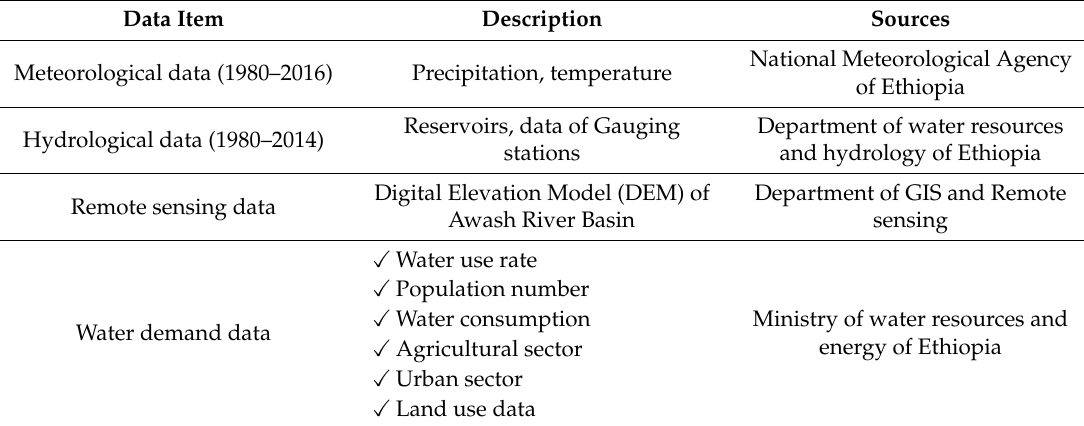
Table 1. Input datasets of the water evaluation and planning (WEAP) modeling in the Awash River